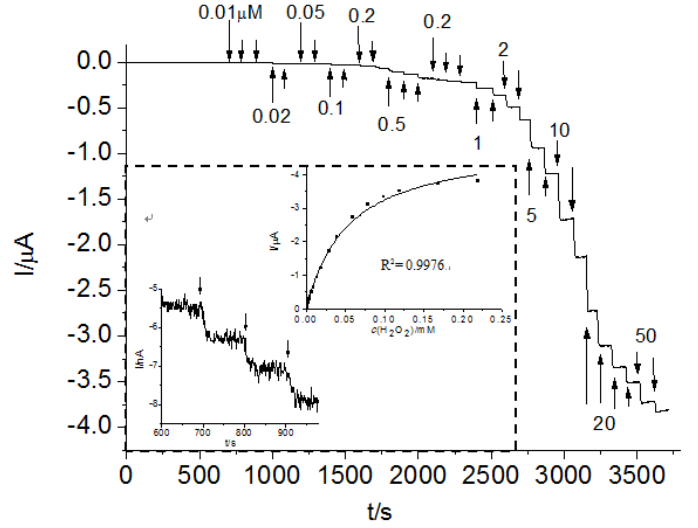
O concentration; the lower left inset zooms in on 2 2 O injected. 2 2